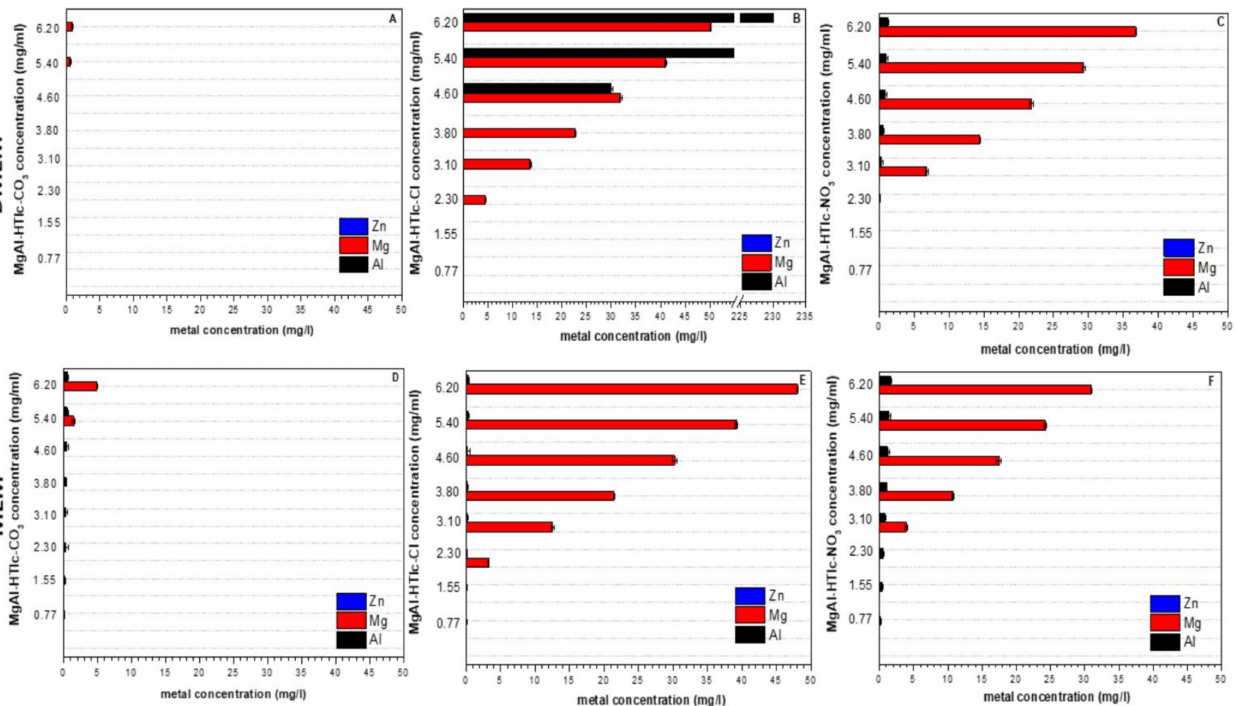
Figure 3. Concentrations of Al 3+ , Mg 2+, and Zn 2+ more exceeding that found in the controls: MEM and DMEM. Supernatants of: ( A ) MgAl-HTlc-CO 3 in DMEM; ( B ) MgAl-HTlc-Cl in DMEM; ( C ) MgAl- HTlc-NO 3 in DMEM; ( D ) MgAl-HTlc-CO 3 in MEM; ( E ) MgAl-HTlc-Cl in MEM; ( F ) MgAl-HTlc-NO 3 in